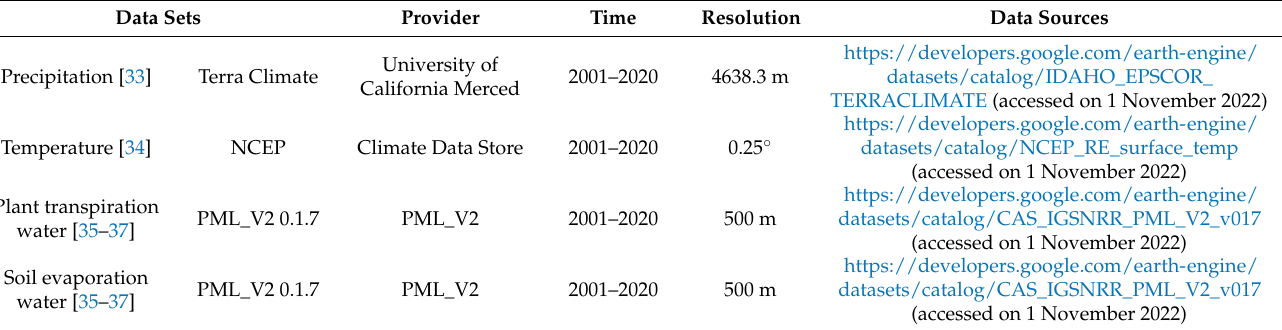
Table 1. Sources of meteorological